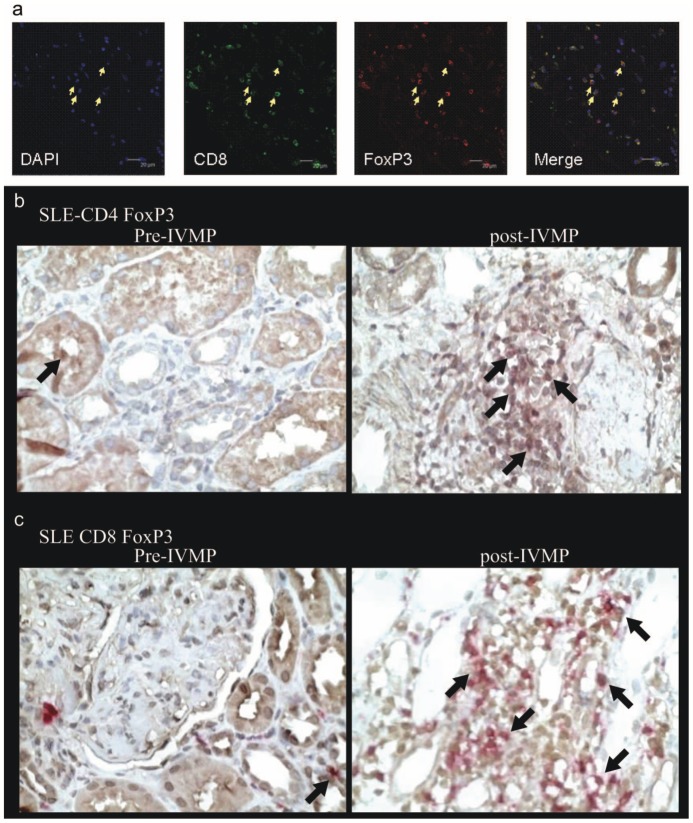
Confocal microscopic analysis of renal biopsy in active Class IV LN patient before IVMP pulse therapy.(a) Specimen was stained for CD8, FoxP3, and 4′, 6-diamidino-2-phenylindole (DAPI) (nuclear stain). White arrows indicate CD8+FoxP3+ cells. (b) (c) right CD4+FoxP3+ and CD8+FoxP3+Treg cell expression significantly decreased before IVMP pulse therapy in renal tissue of Class IV LN (n = 50) FoxP3+ (brown); CD4+ or CD8+ (pink). (b) (c) left CD4+FoxP3+ and CD8+FoxP3+ Treg cell expression significantly increased after IVMP pulse therapy in renal tissue of follow-up biopsies in Fig. 2a patient.